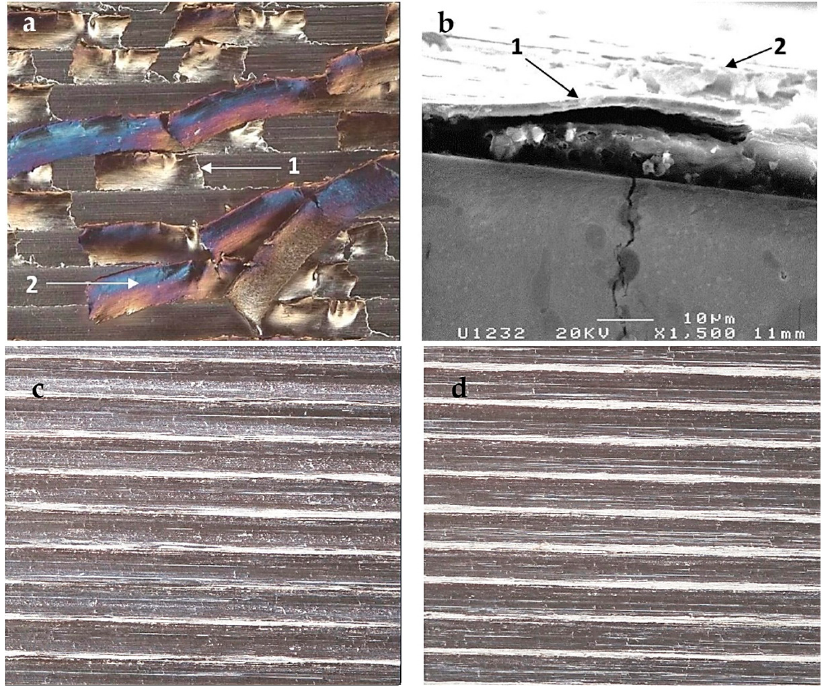
Figure 5. ( a , b ): The surface treated with an uncoated T1 tool with the feed value f 2 = 0.2 mm/rev.; 1—side flow of the material, 2—chip glued on the surface; ( c , d ): the surfaces treated with coated T2 ( c ) and T3 ( d ) tools with the feed value f 2 = 0.2 mm/rev.; magnification 200×.